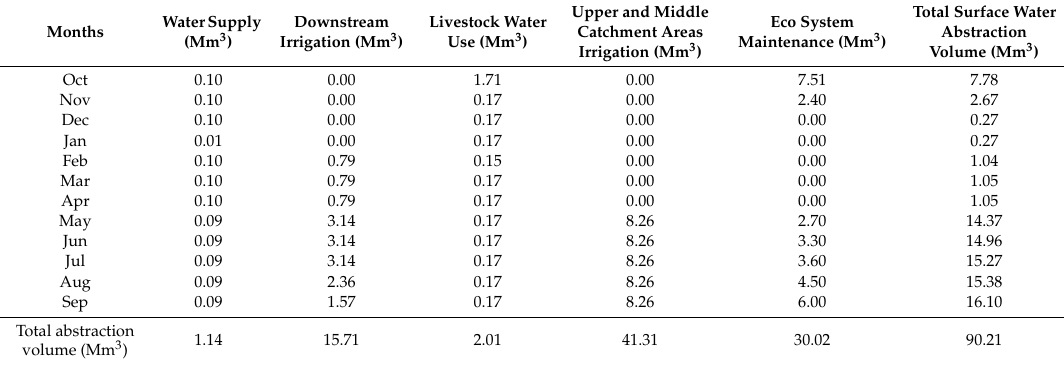
Figure 9. Water abstractions at the demand nodes in the WEAP model. Figure 9 . Water abstractions at the demand nodes in the WEAP model . Table 6. TotalvolumeofsurfacewaterabstractionforChongweRiverCatchment(obtainedfromtheWEAP). Table 6 . Total volume of surface water abstraction for Chongwe River Catchment (obtained from the WEAP) .